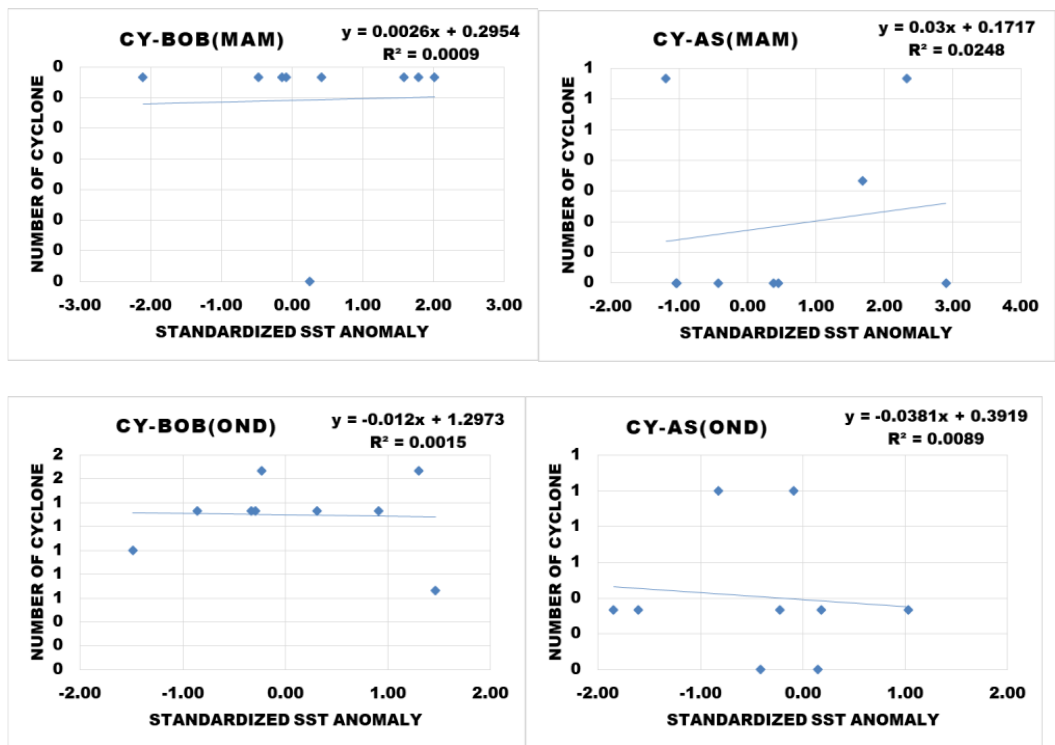
Figure 5. Scatter plots between standardized SST anomalies and number of cyclones (CY) for the negative IOD years for BOB − MAM, AS − MAM, BOB − OND and AS − OND.